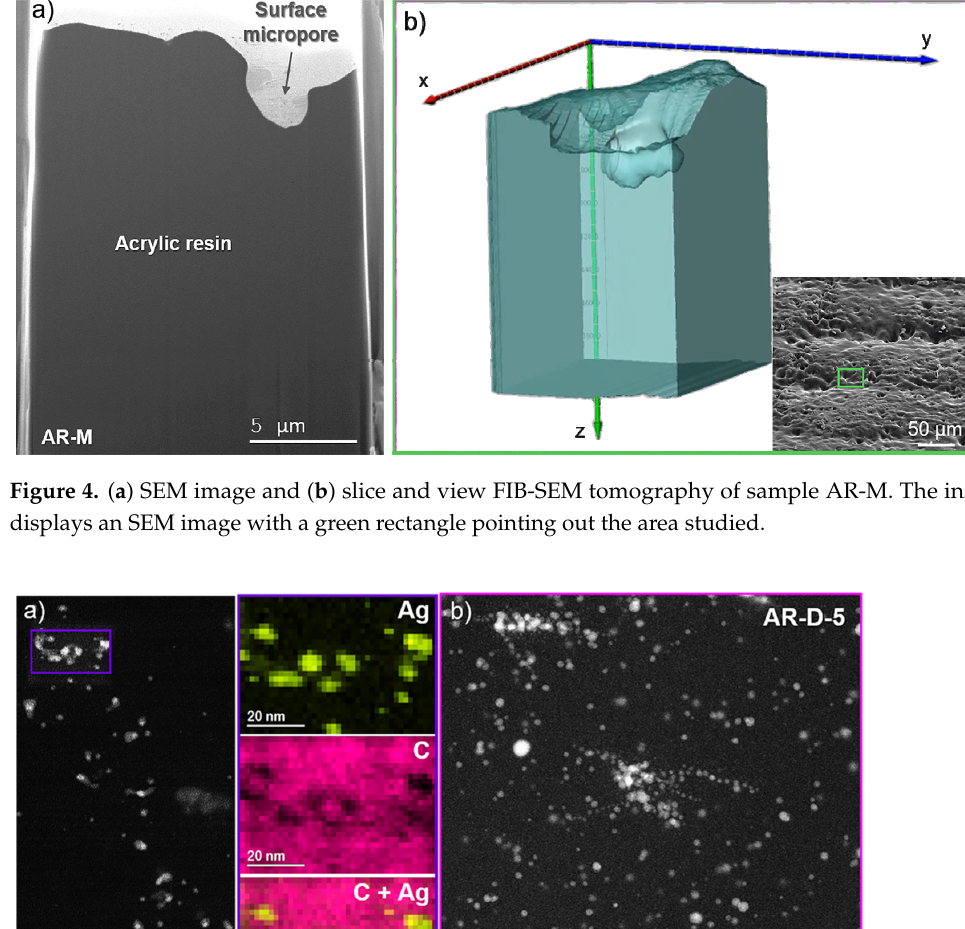
8 of 14 Figure 3. SEM images of samples AR ( a , b ), AR-M ( c , d ), and AR-D ( e , f ) obtained at lower (left) and higher (right) magnifications. Due to the results obtained by SEM and in order to explore the presence of internal pores within the cured acrylic resin, slice and view FIB-SEM tomography were conducted, and the results for sample AR-M can be found in Figure 4. Figure 4a shows an SEM image of one of the cross-section slices obtained, showing the interior of the material, and Figure